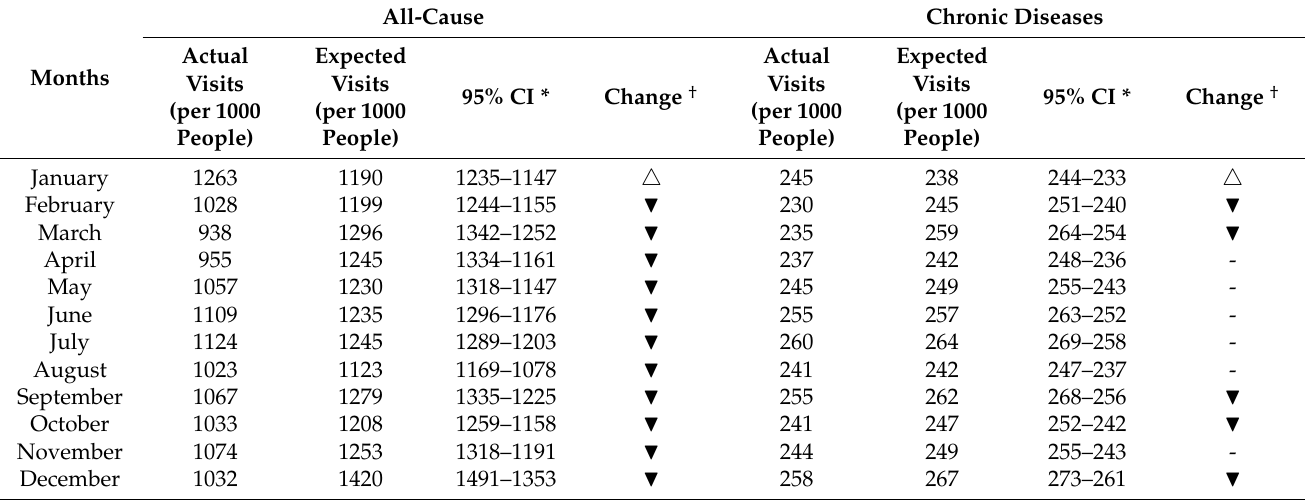
Table 2. Assessment of the Pandemic’s Impact on Monthly OP visits in 2020.